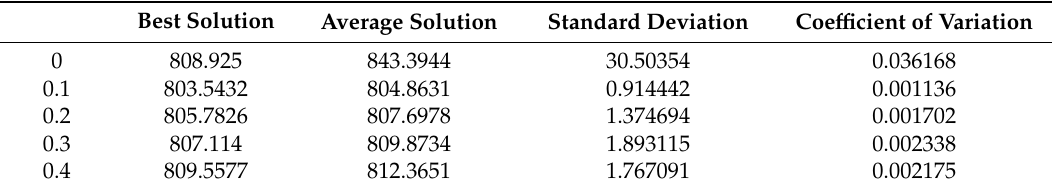
Table 4. Perturbation operation probability rand.